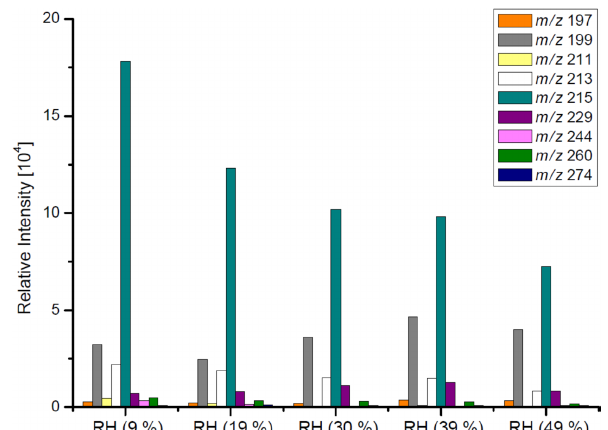
Figure 3. LC-MS chromatographic responses of OS and NOSs from the non-acidic-seed experiments